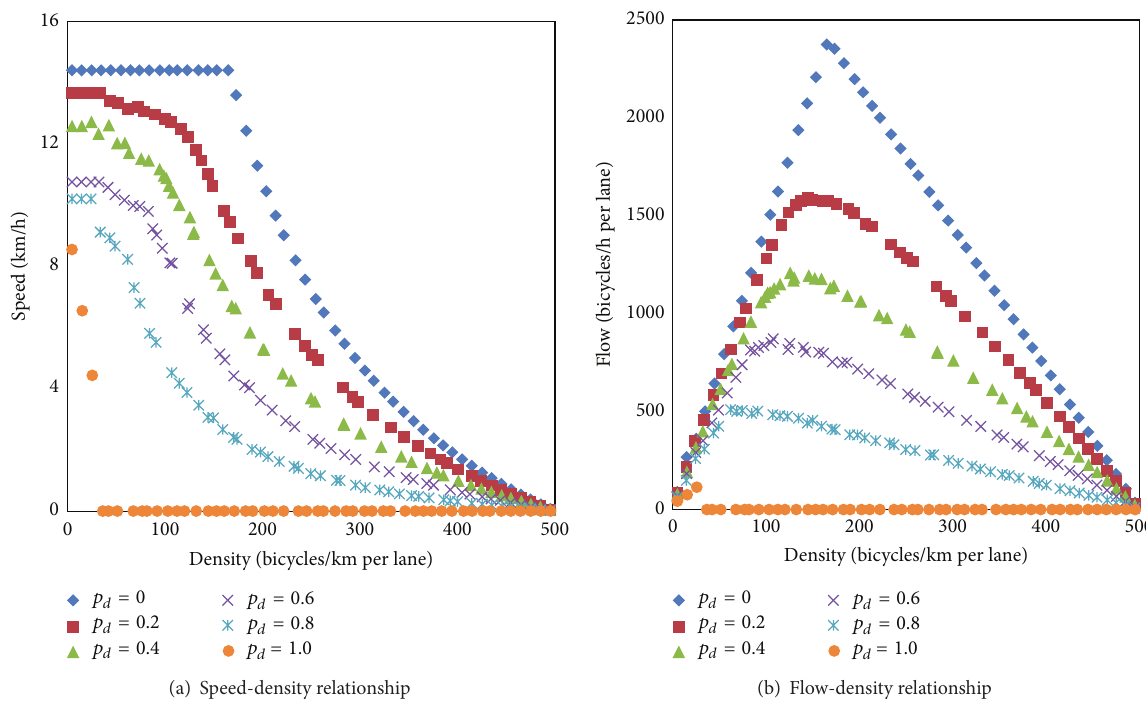
Figure 1: Speed-density and flow-density relationships under different slowing down probabilities when 𝑝 𝑡 = 0.8 and 𝑝 𝑒 = 0.5.